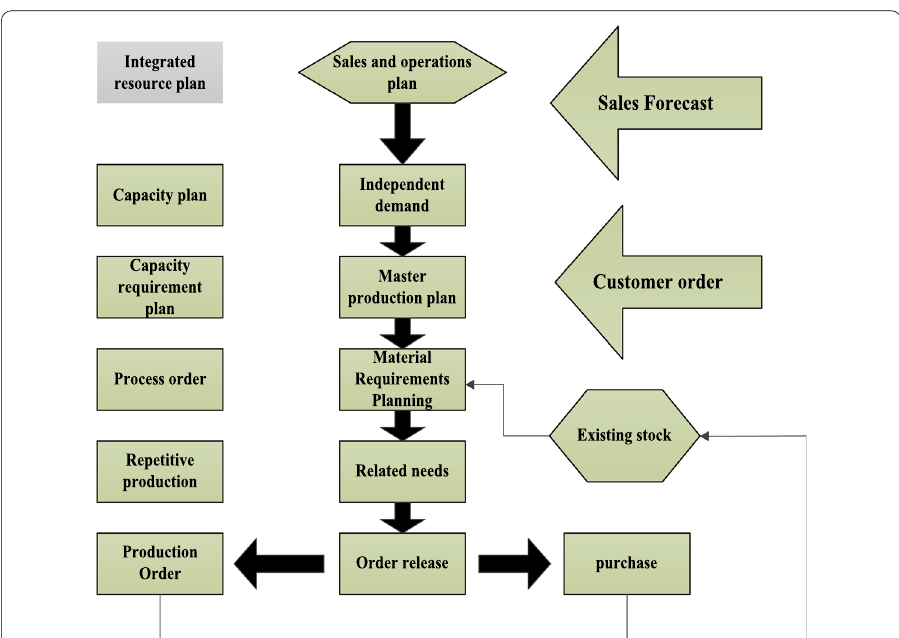
Fig. 4 Diagram of material management module and other modules